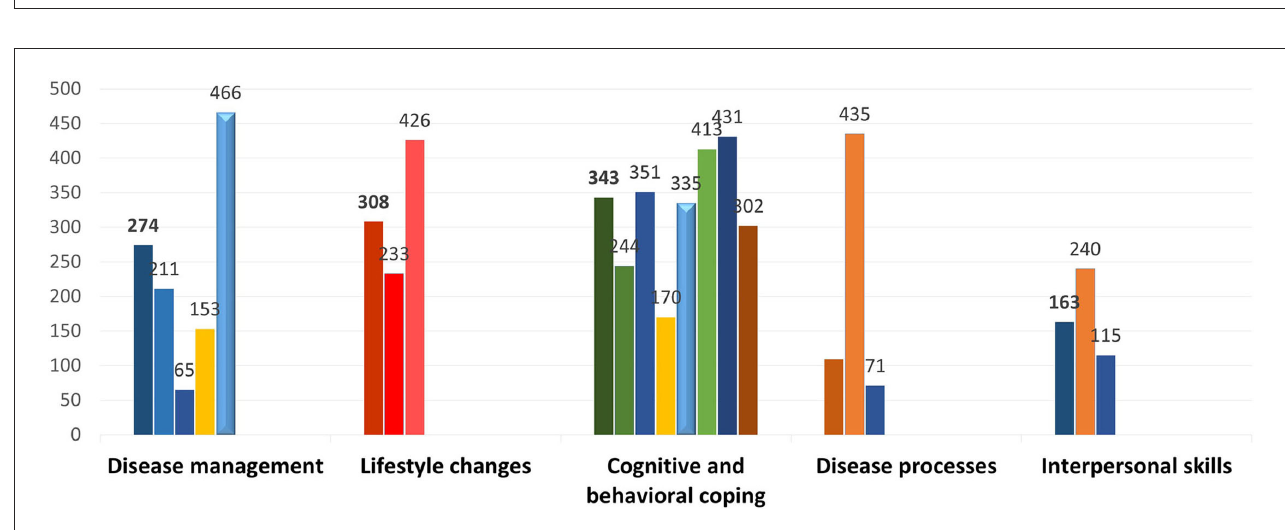
FIGURE4 Strategies and skills taught as part of therapeutic patient education